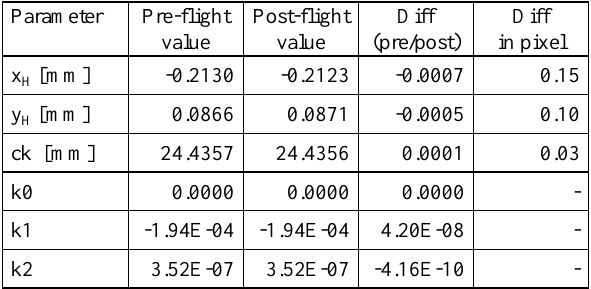
Table 2: Results of pre- and post-flight calibration